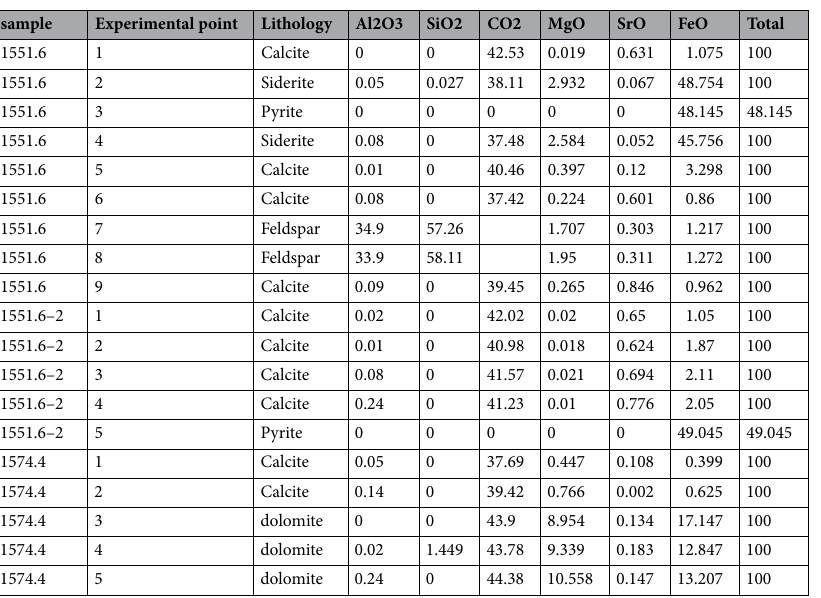
Table 1. Major elements. The experimental points of sample